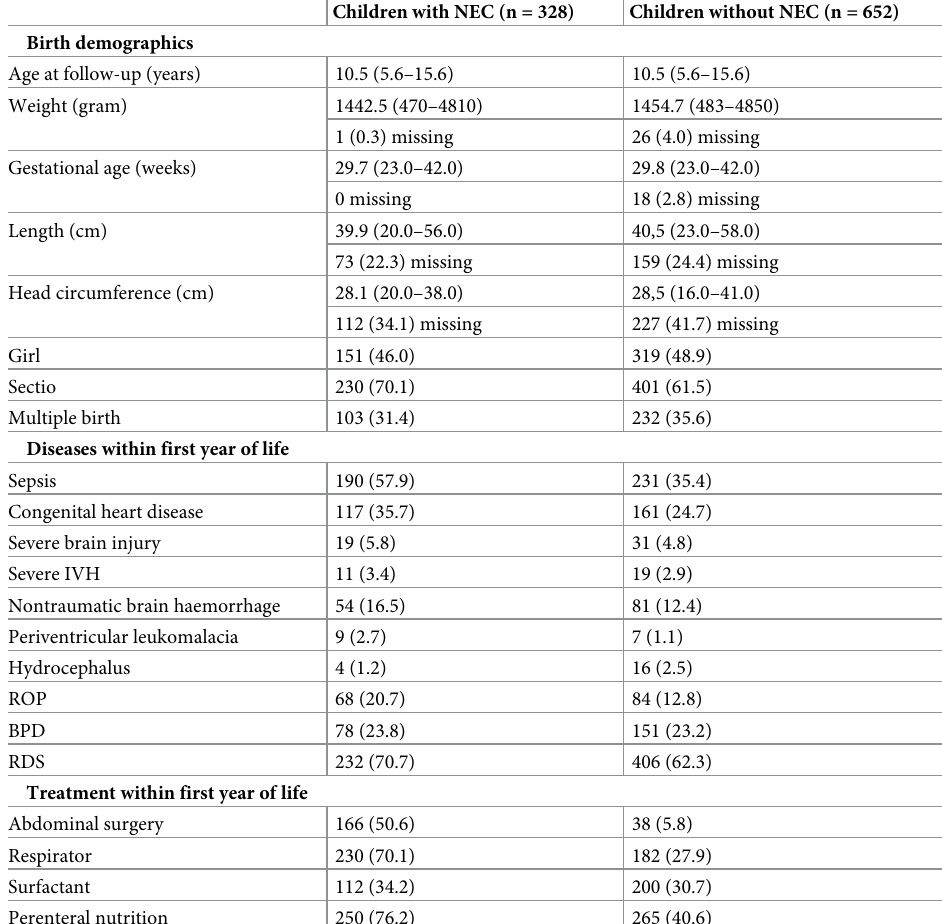
Table 2. Baseline characteristics for the children with NEC and children without